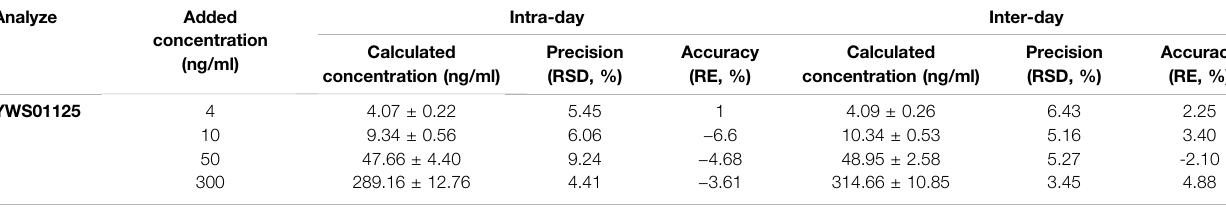
TABLE 1 | Precision and accuracy of UPLC-MS/MS for drugs in the mouse plasma ( n = 6). Analyze